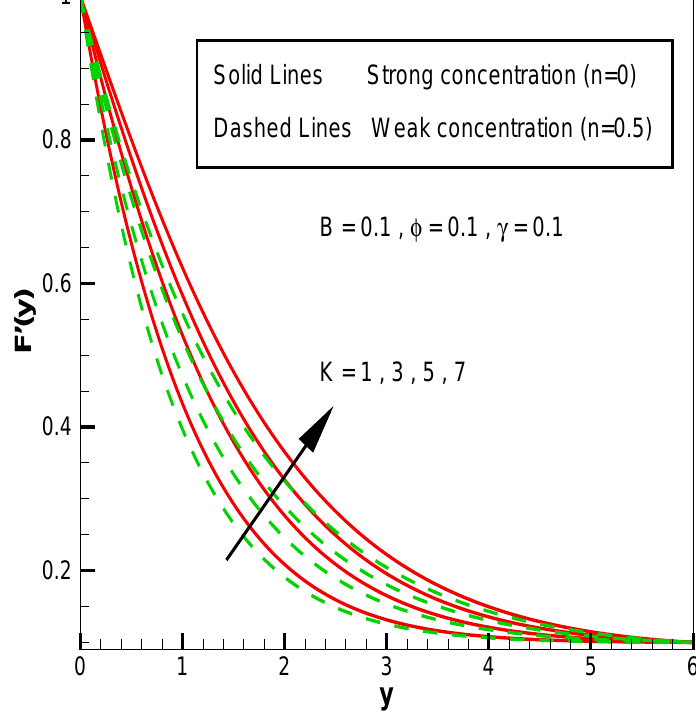
Figure 2. F (cid:48) ( y ) for material parameter K Figure 2. 𝐅 (cid:4593) (𝐲) for material parameter 𝐊 .